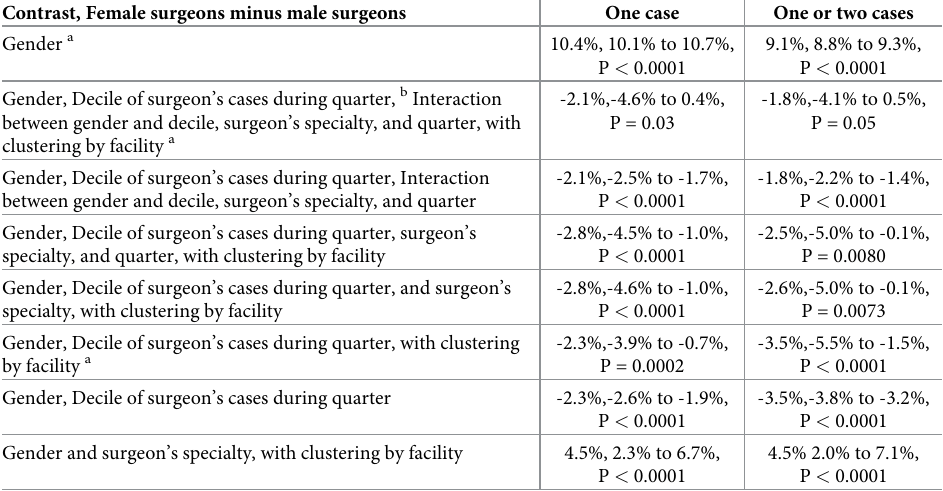
Table 4. Contrasts between male and female surgeons, reported as mean difference of percentages, 99% confi- dence interval, and two-sided P-value, N = 1,509,190 lists. Contrast, Female surgeons minus male